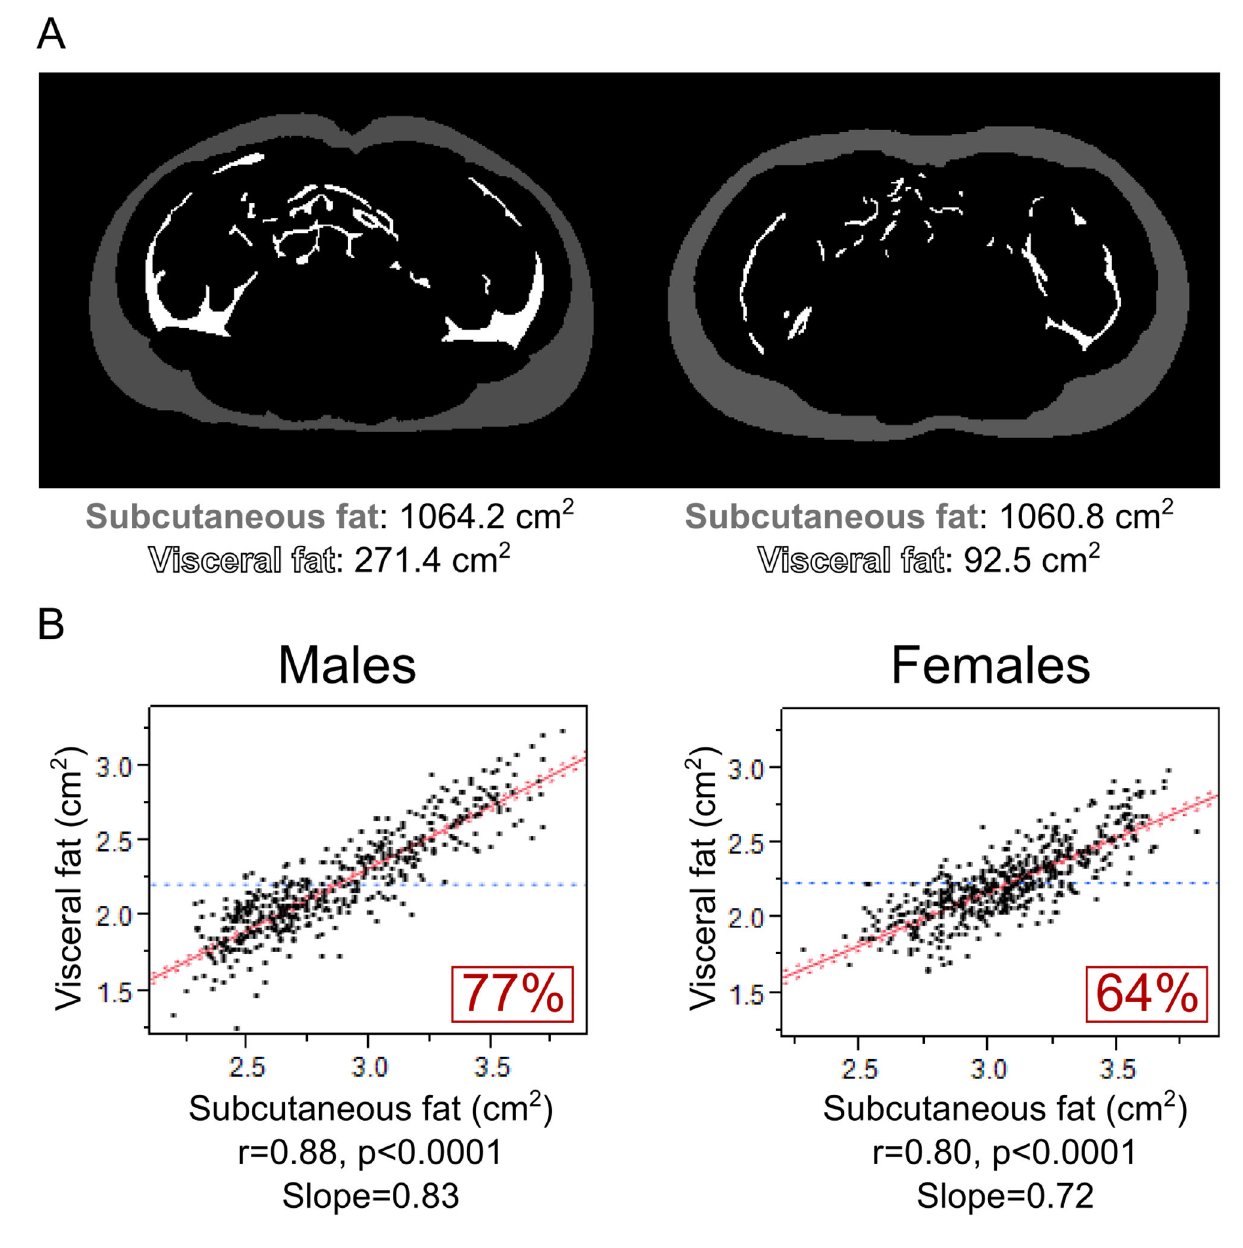
Figure 1. Relationships of VF with SF in adolescent males and females. A) Magnetic resonance images of analyzed umbilical slices in 2 individuals with similar subcutaneous fat and different visceral fat. B) Univariate correlations between of VF with SF are shown in adolescent males and